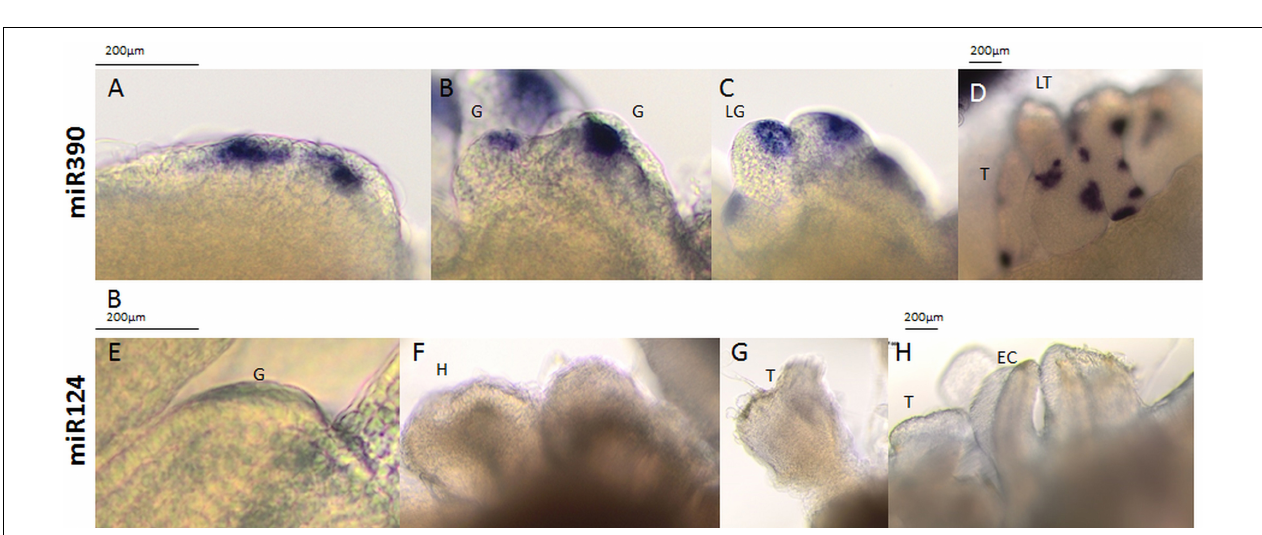
FIGURE 5 | Whole mount in situ hybridization of the miR166 molecules in the explants undergoing SE induction in the STTM165/166 line after treatment with 70% glycerol (A–C) and the clearing solution (D–F) at 0th day (A,D) , 5th day (B,E) , and 10th day (C,F) of culture. Arrow heads indicate the detected signal.